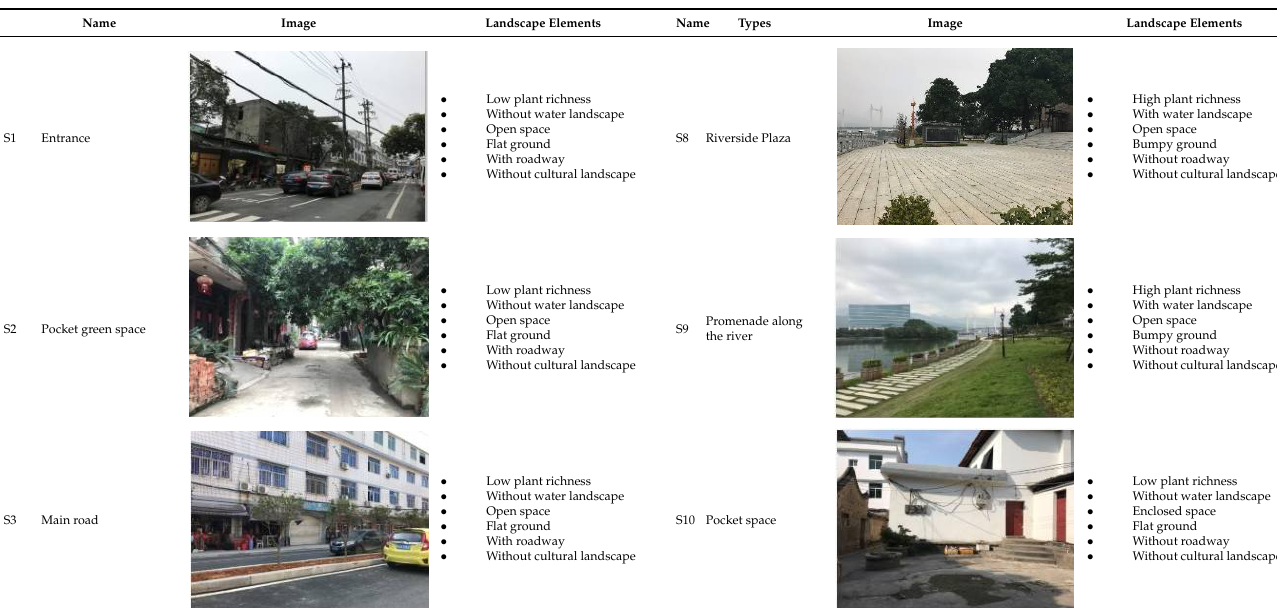
Figure 1. Aerial image of the Linpu experiment area redrawn based on Google map. Table 1. Characteristic of experiment sites in Linpu villageSite.